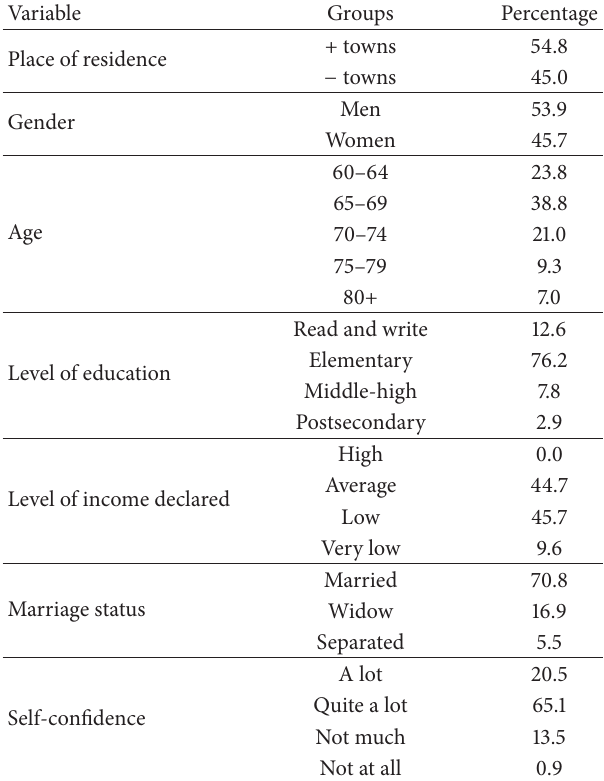
Table 1: Distribution of the sample of older adults ( 𝑁 = 191